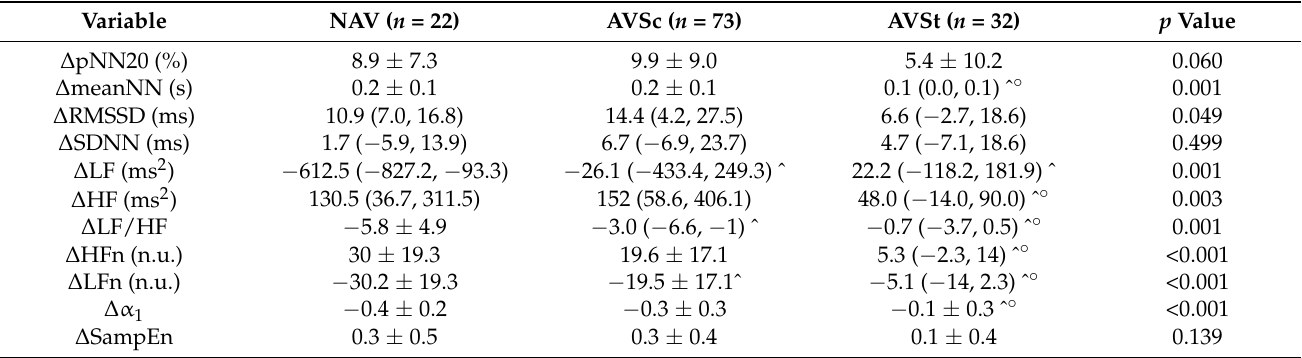
Table 4. Magnitude ( ∆ ) of change in heart rate variability indices in response to active standing. Data are shown as mean ± standard deviation, or median (percentile 25, percentile 75). The n specifies the number of subjects in each